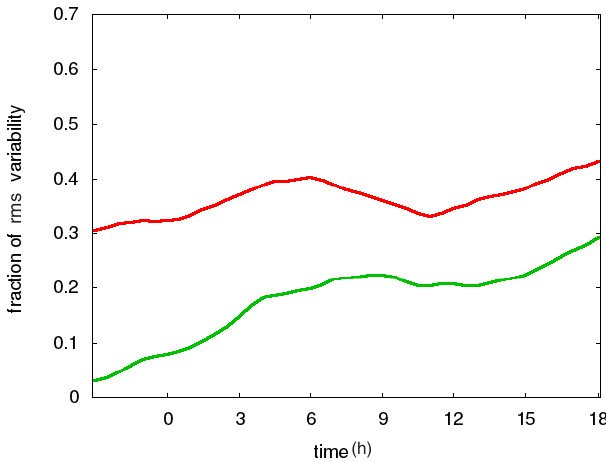
Figure 1. The rms forecast error of control trajectories with dif- ferent initial errors. Times indicated on the x axis correspond to UTC times of 26 September 2006. Values on the y axis are non- dimensional (TUV norm defined in the text) and are expressed as fractions of natural variability. Red: trajectory labelled 18H (actu- ally starting at 18:00UTC on 25 September), which at 21:00UTC has error 0.3, of the order of the present-day analysis error. Green: trajectory labelled R21, obtained from the previous one by rescal- ing, at 21:00UTC on 25 September, its error to 0.03, i.e. 1 order of magnitude smaller than the present-day analysis error